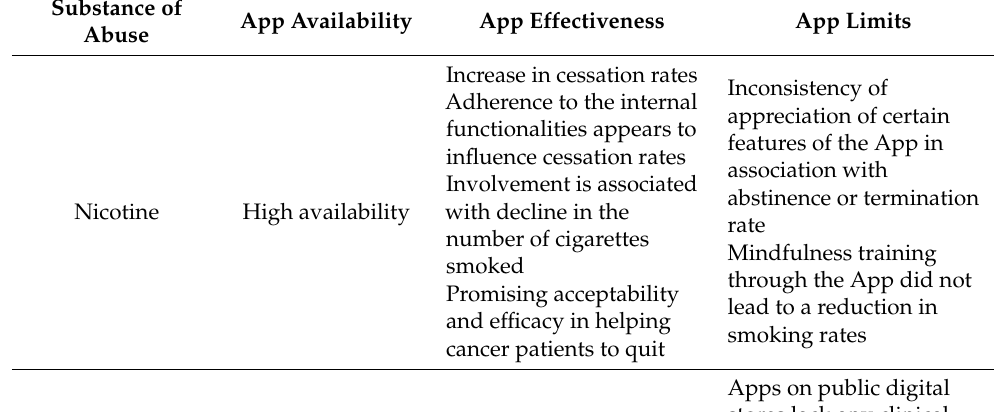
Inconsistency of appreciation of certain features of the App in association with abstinence or termination rate Mindfulness training through the App did not lead to a reduction in smoking